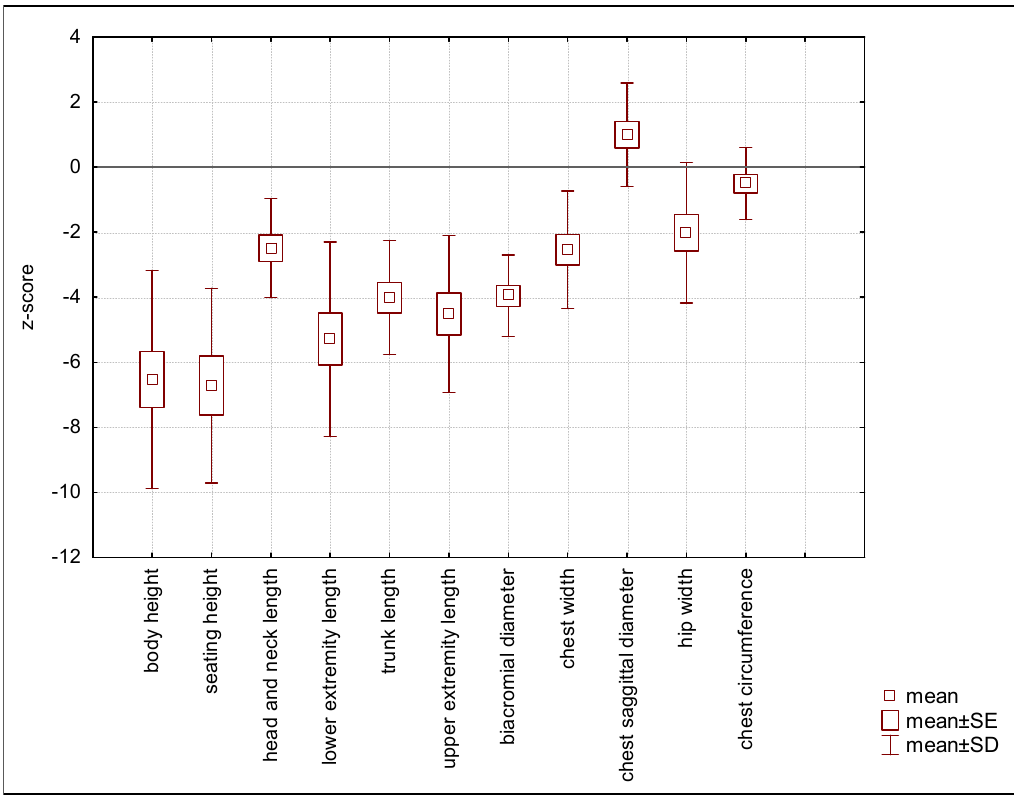
Figure 2. Values of craniofacial features. Diagnostics 2020 , 10 , x FOR PEER REVIEW